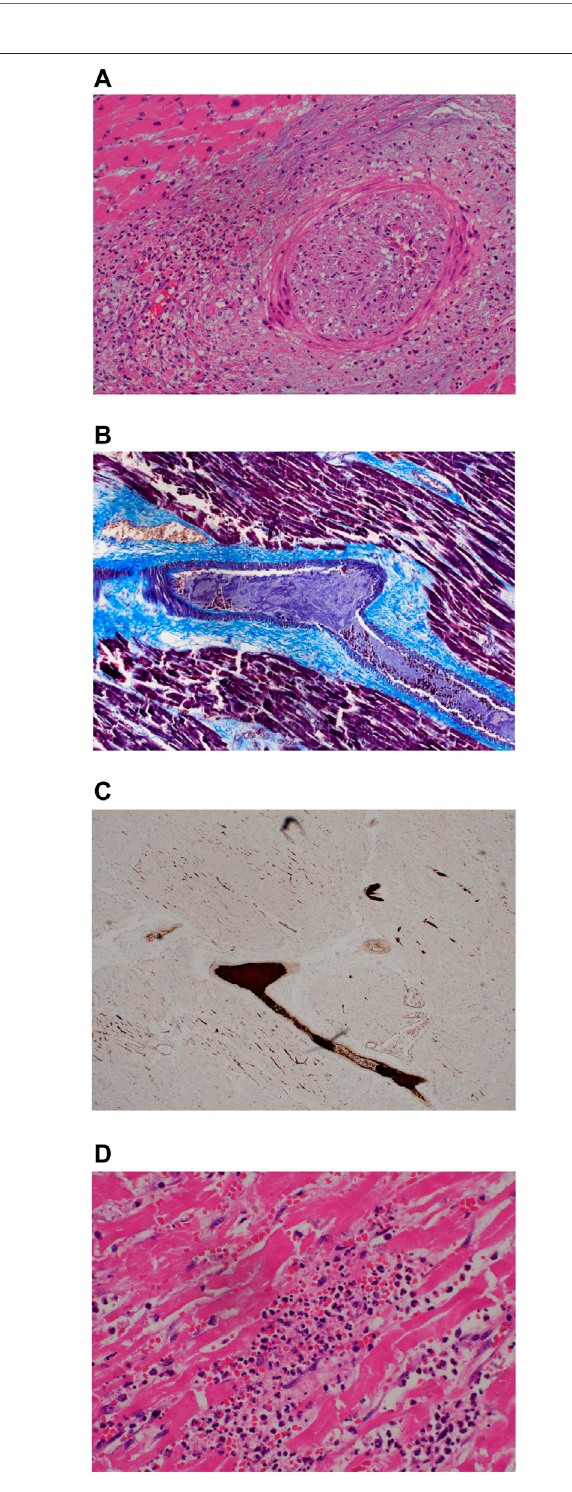
FIGURE 3 | (A) Occlusion of coronary artery lumen by proliferation of spindled cells (H&E, x200). (B) Fibrin thrombi. MSB stain (200x). (C) Platelet thrombi, CD61 immunohistochemical stain (200x).